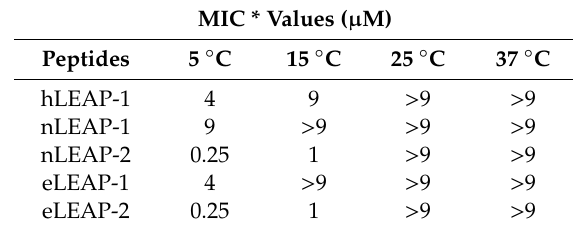
Table 3. Temperature-dependent antimicrobial activity of peptides: hLEAP-1 (human), nLEAP-1, nLEAP-2 ( D. mawsoni ), and eLEAP-1, eLEAP-2 ( Lys. dearborni ) against Listeria monocytogenes at 5, 15, 25, and 35 ◦ C. The peptides e ff ectively inhibited the growth of L. monocytogenes at low temperatures. The nLEAP-2 and eLEAP-2 showed the highest antibacterial activity at low temperatures. MIC * Values ( µ